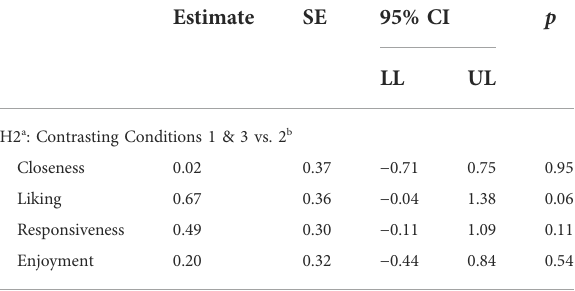
TABLE 2 MLM Results for Af fi liative Outcomes by Avatar Match.